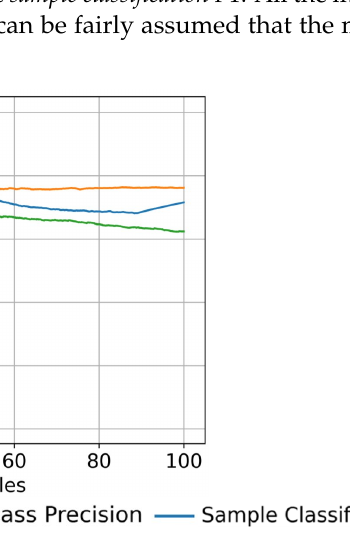
Figure 5. Evolution over time of the metrics with the final parameters set in the gallery construction process using the MARS dataset